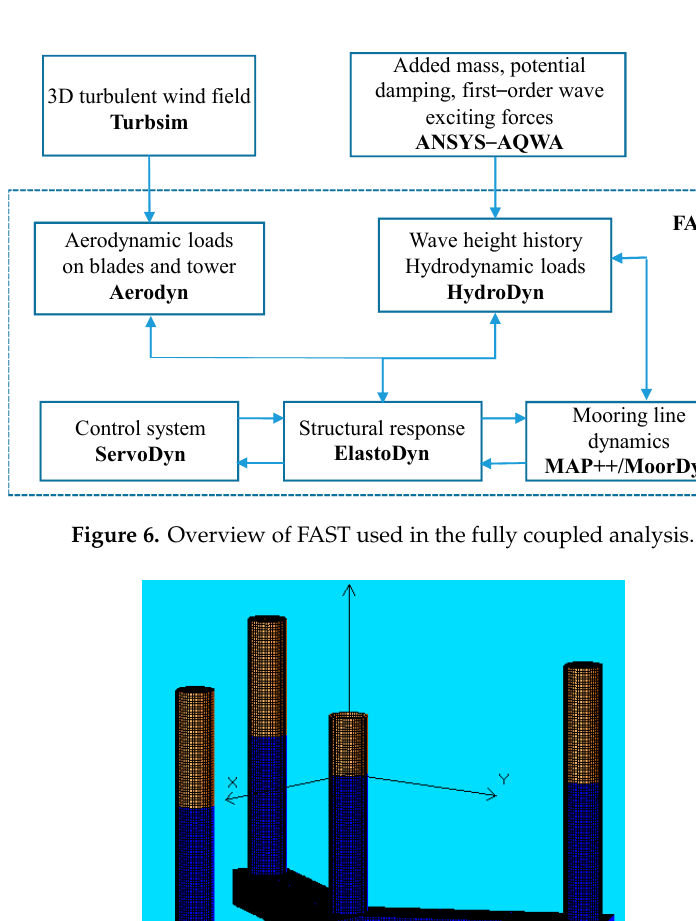
Table 5. Natural frequencies of the NREL (National Renewable Energy Laboratory) 5 MW and DTU (Danish University of Science and Technology) 10 MW FOWTs.